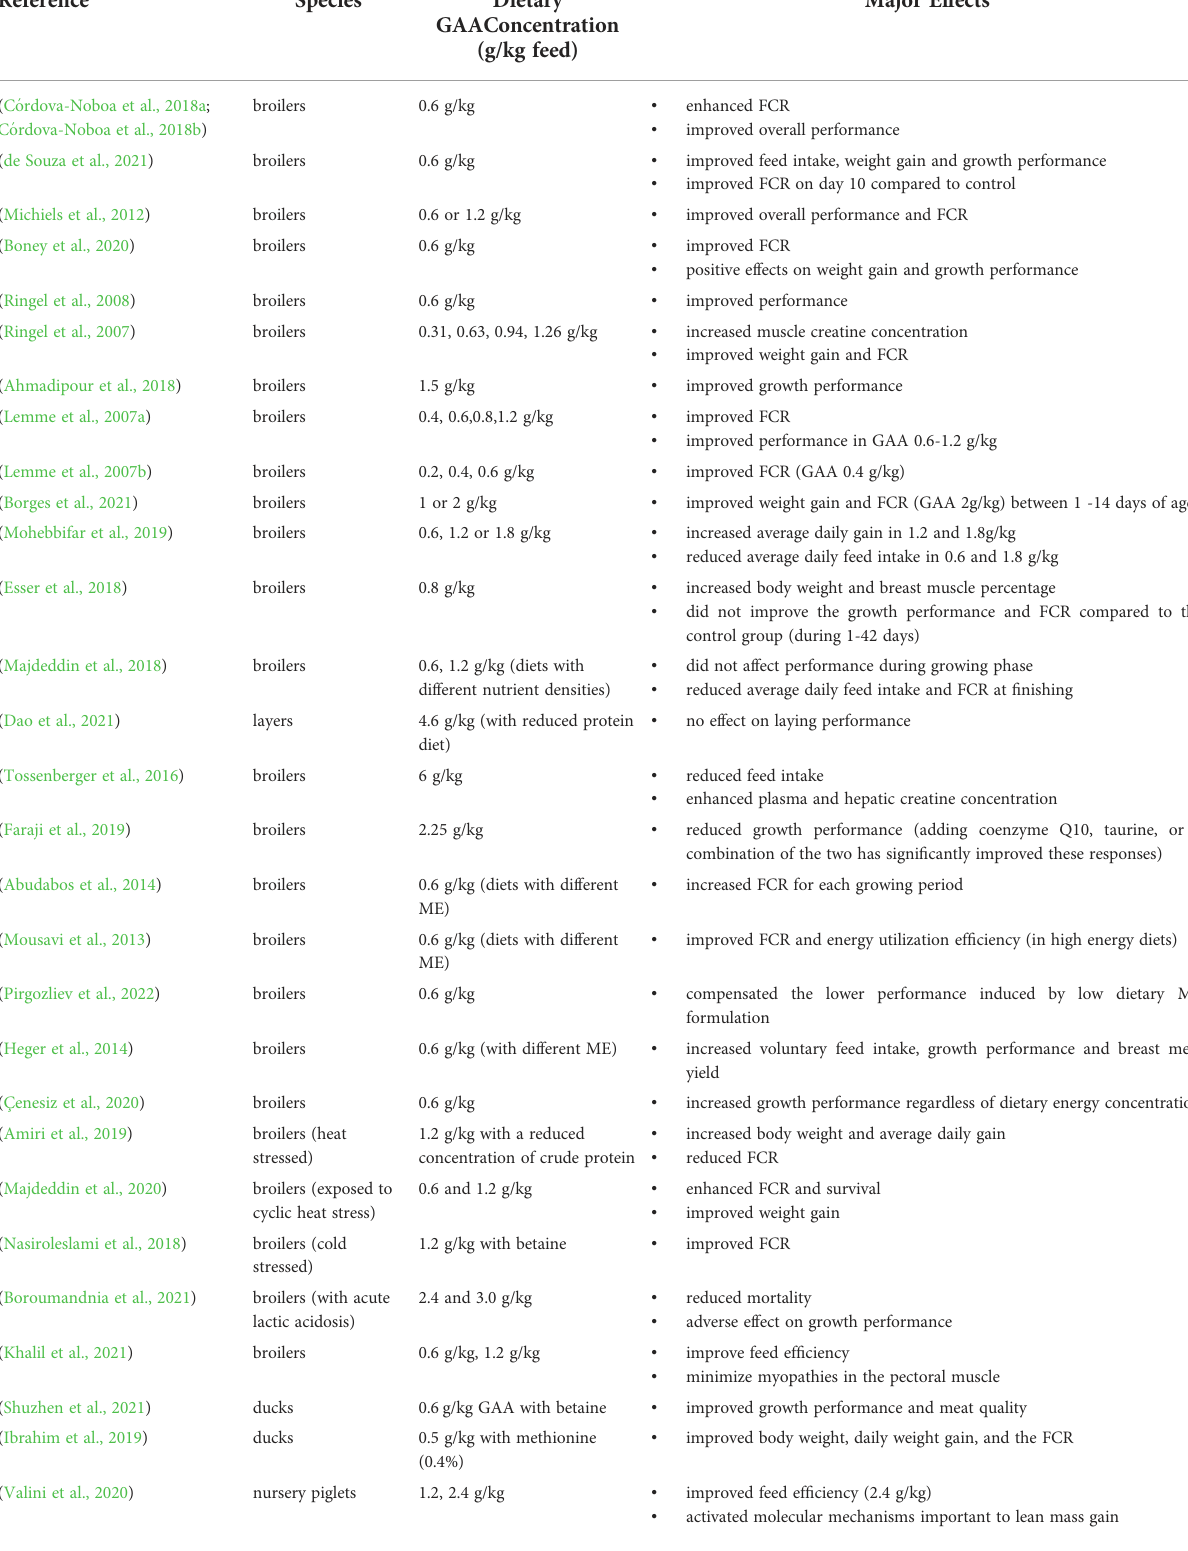
TABLE 2 An overview of the research concerning the effects of GAA supplementation on growth performance in poultry and